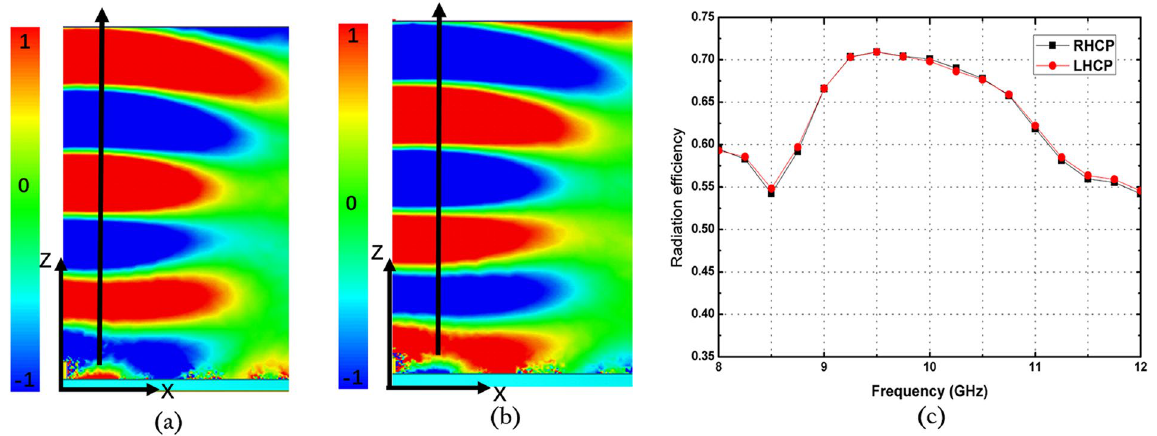
Figure 9. Near-field distribution in the X–Z plane at 10 GHz and radiation efficiency of the antenna. ( a ) E y excited by the LHCP antenna, ( b ) E y excited by the RHCP antenna, and ( c ) radiation efficiency of the antennas at different frequencies.